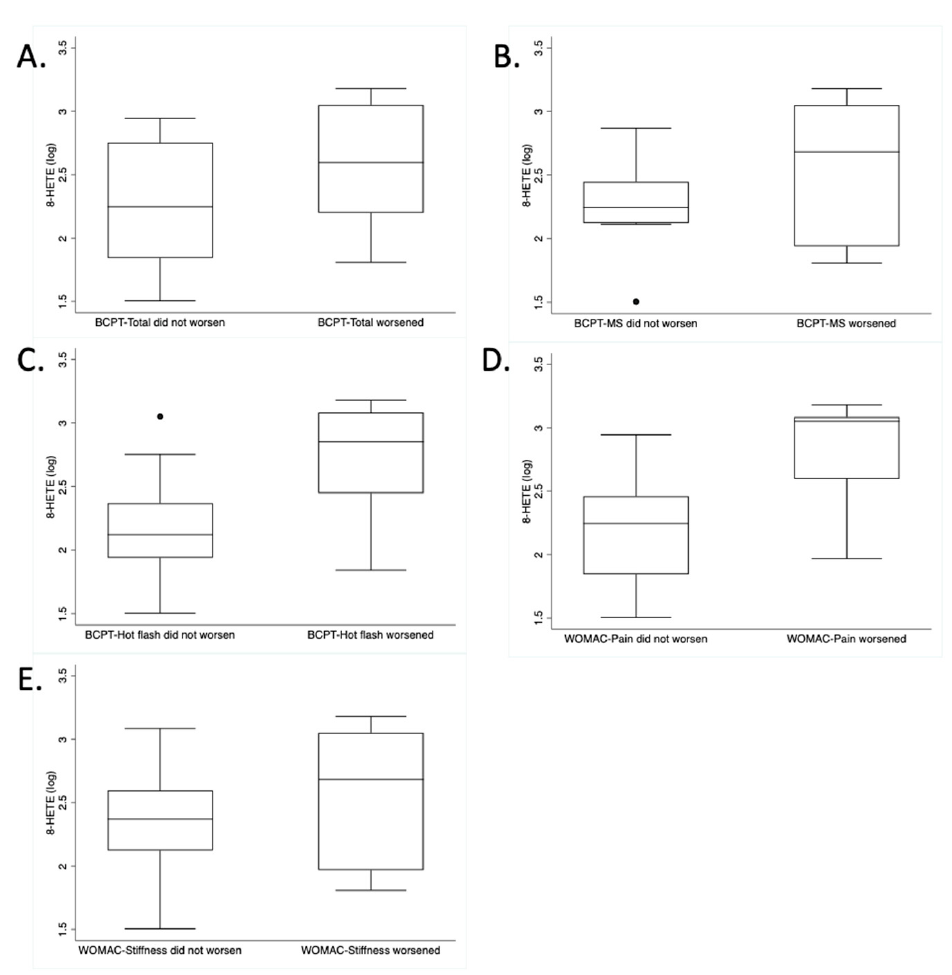
Figure 2. Box plots of batch-adjusted, log-transformed 8-HETE measures among the participants who did and did not experience worsening symptoms over 6 months, according to 5 di ff erent questionnaire subscales: ( A ) BCPT-total, ( B ) BCPT-MS, ( C ) BCPT-hot fl ash, ( D ) WOMAC-pain, and ( E ) WOMAC-sti ff ness. In separate linear mixed-e ff ects models, 8-HETE was signi fi cantly